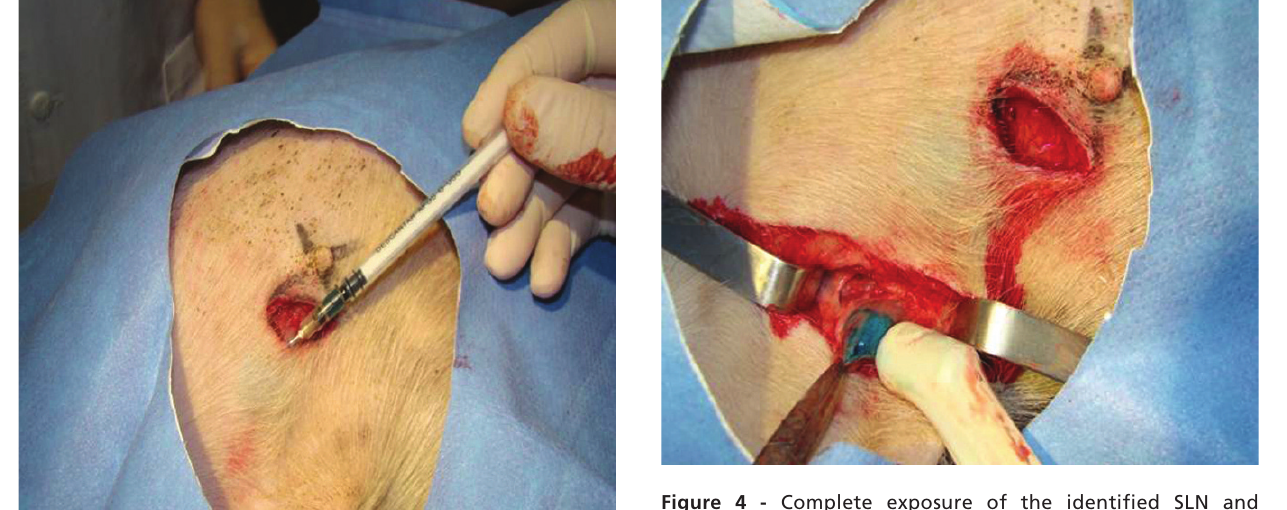
Figure 4 - Complete exposure of the identified SLN and measurement of the radiocolloid uptake in vivo before the removal of the SLN.